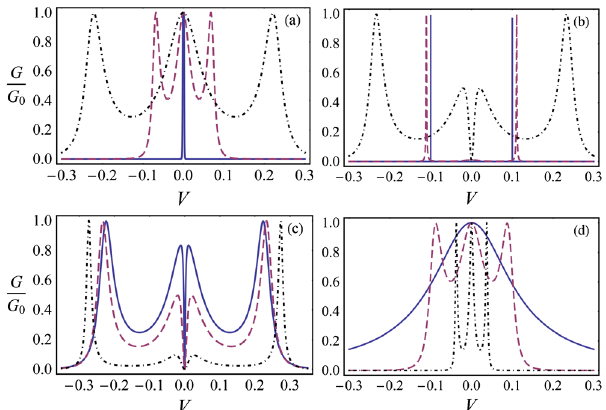
FIG. 6. Zero-temperature tunneling conductance G ð V Þ as a function of various parameters. Here, all energies are rescaled by Γ and G 2 e 2 =h . (a) δ ¼ 0 , ε ¼ − 3 . 5 , and λ ¼ 0 . 05 (solid 0 ¼ line), λ ¼ 0 . 5 (dashed line), and λ ¼ 1 . 0 (dash-dotted line). (b) The same as (a) but δ ¼ 0 . 1 . (c) λ ¼ 1 , ε ¼ − 3 . 5 , and δ ¼ 0 . 05 (solid line), δ ¼ 0 . 1 (dashed line), and δ ¼ 0 . 2 (dash-dotted line). (d) λ ¼ 0 . 5 , δ ¼ 0 . 1 , and ε ¼ − 1 (solid line), ε ¼ − 3 (dashed line), and ε ¼ − 5 (dash-dotted